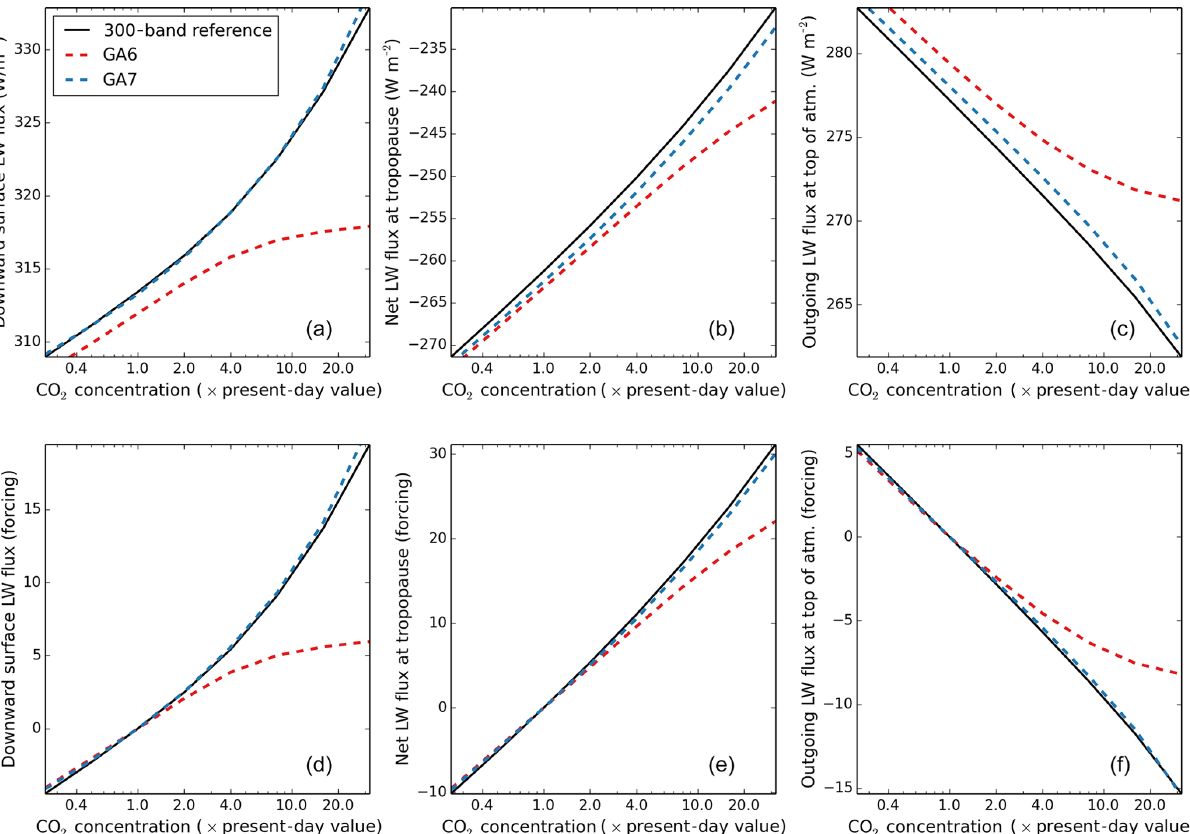
Figure 1. Comparison of LW flux errors due to changes in CO 2 concentration using GA6 and GA7 gaseous absorption compared to a 300- band LW reference configuration. Plots show an average response over the four clear-sky atmospheric profiles used for CIRC (Oreopoulos et al., 2012) which represent a broad range of water vapour path lengths. The top row shows the actual mean fluxes over the four profiles, whilst the bottom row shows the flux differences compared to a run using present-day CO 2